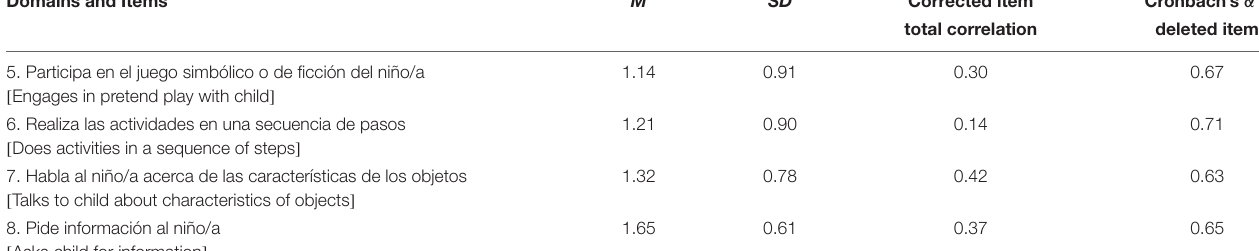
a good ( χ 2 /df < 2, CFI > 0.95 and TLI > 0.95) or, at least, acceptable (RMSEA < 0.08) fit of the